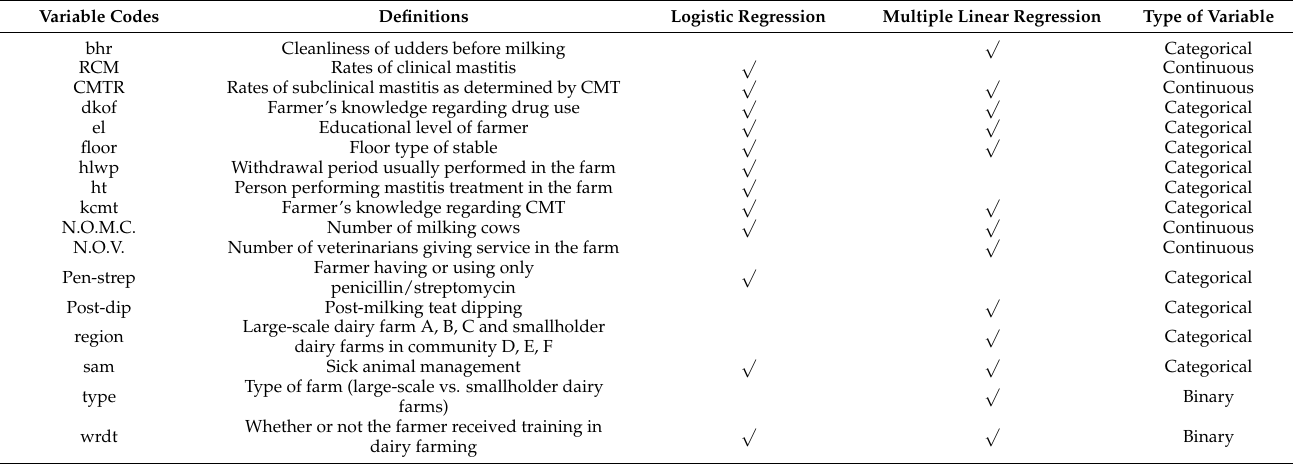
Table 2. Variables included in the initial logistic regression model for antibiotic residues in BTM and the initial multiple linear regression model for rates of clinical mastitis.